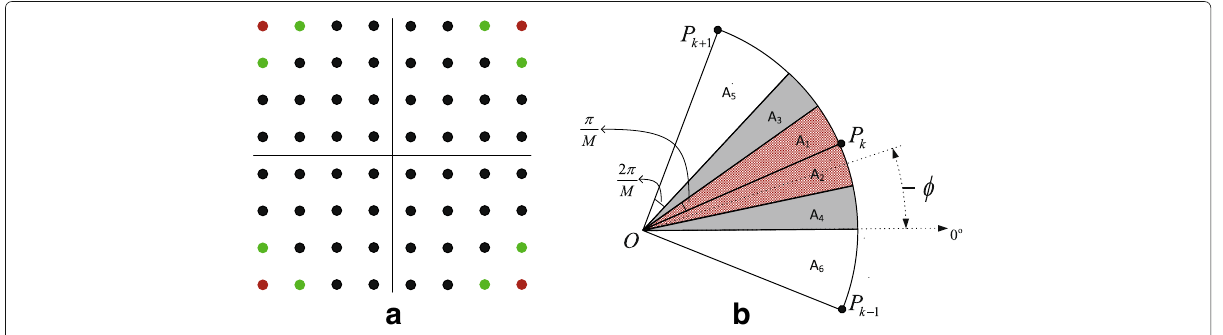
Fig. 3 The optimal and suboptimal signals for a QAM and b PSK φ = ∠ ( h ∗ (cid:9) g ∗ h 1 (cid:9) g 1 ) 2 2 =